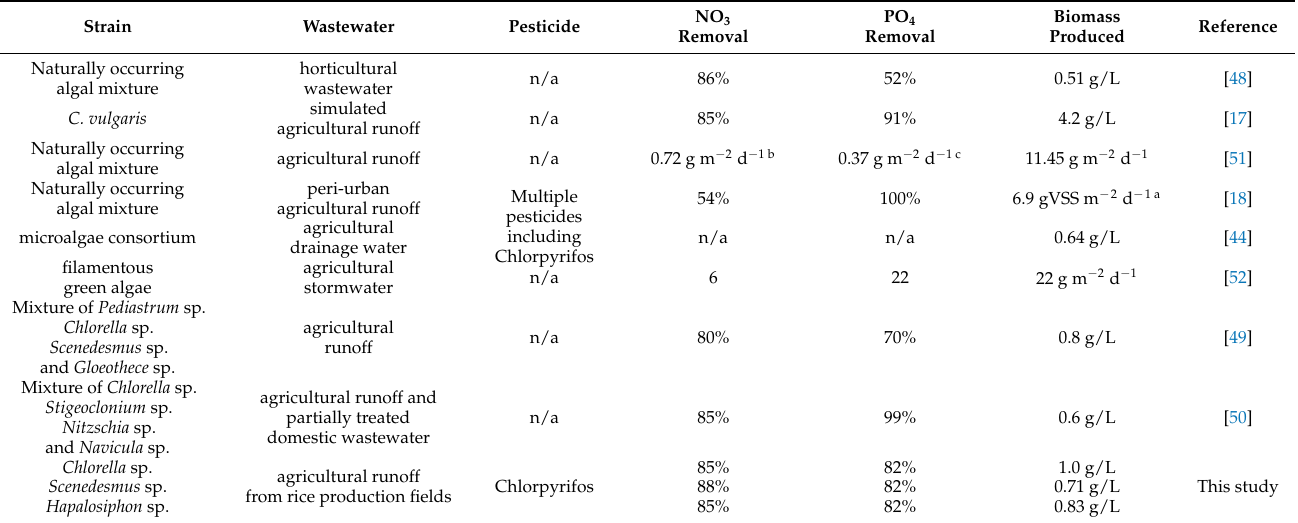
Table 3. Strains cultured on different agricultural